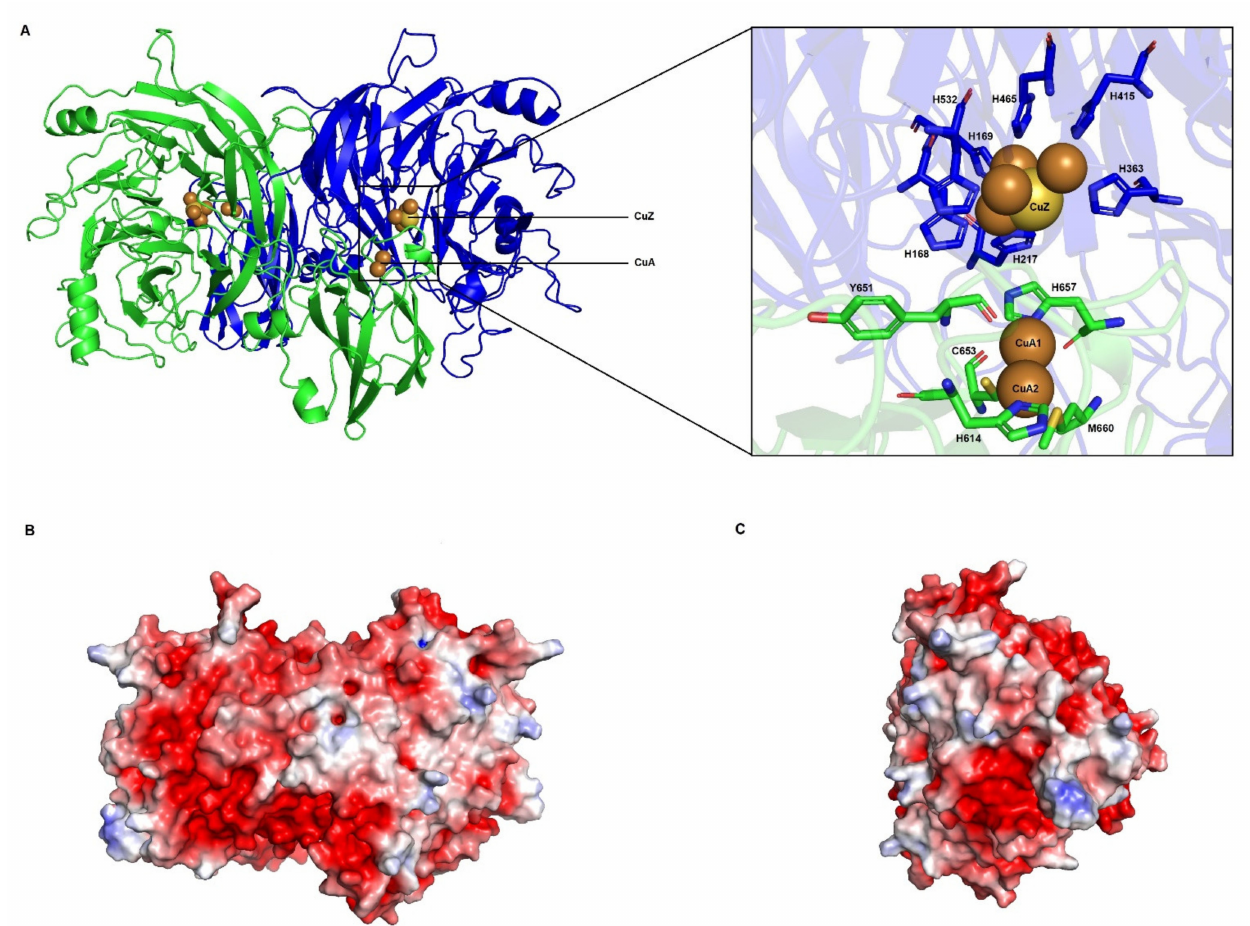
Figure 8. Homology model and electrostatic surface potential of Haloferax mediterranei NosZ ( A ) Three-dimensional model of NosZ in which two subunits (in cartoon) are coloured in green and blue ( left ). CuA centre is represented as two brown spheres whereas CuZ centre is represented as yellow sphere surrounded by four brown spheres. Amino acids involved in Cu centres coordination are shown in sticks ( right ). ( B , C ) Electrostatic surface potential of Haloferax mediterranei NosZ dimer. The electrostatic potential is represented between +5 and -5 kT/e.The image B is in the same position that image A and the image C is rotated 90º with respect to image